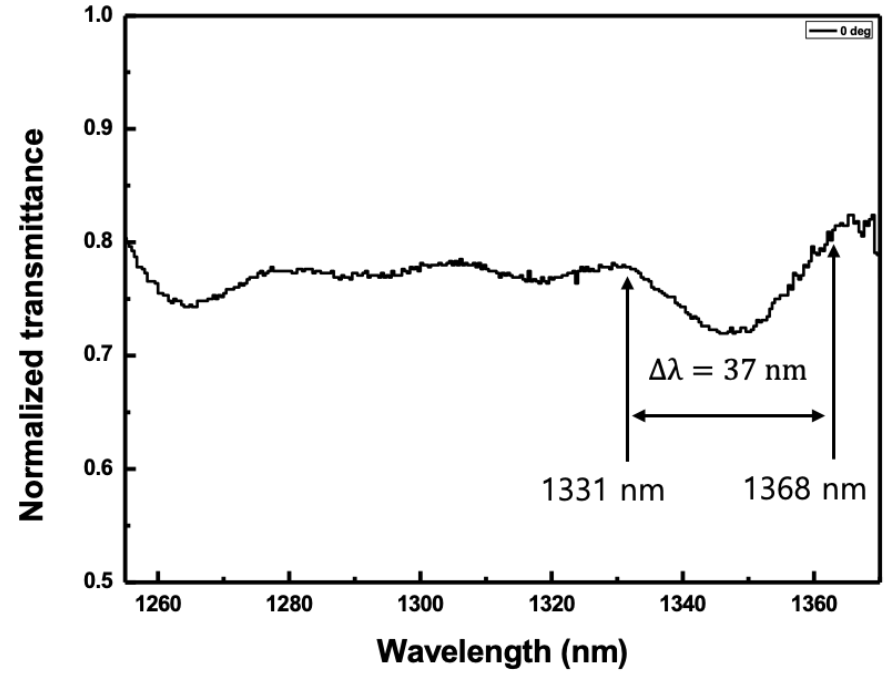
Figure 4. Second-order reflection spectrum when the light was incident to the normal direction of the CLC cell when the electric field applied to the CLC cell was fixed to 0.49 V rms /μm.